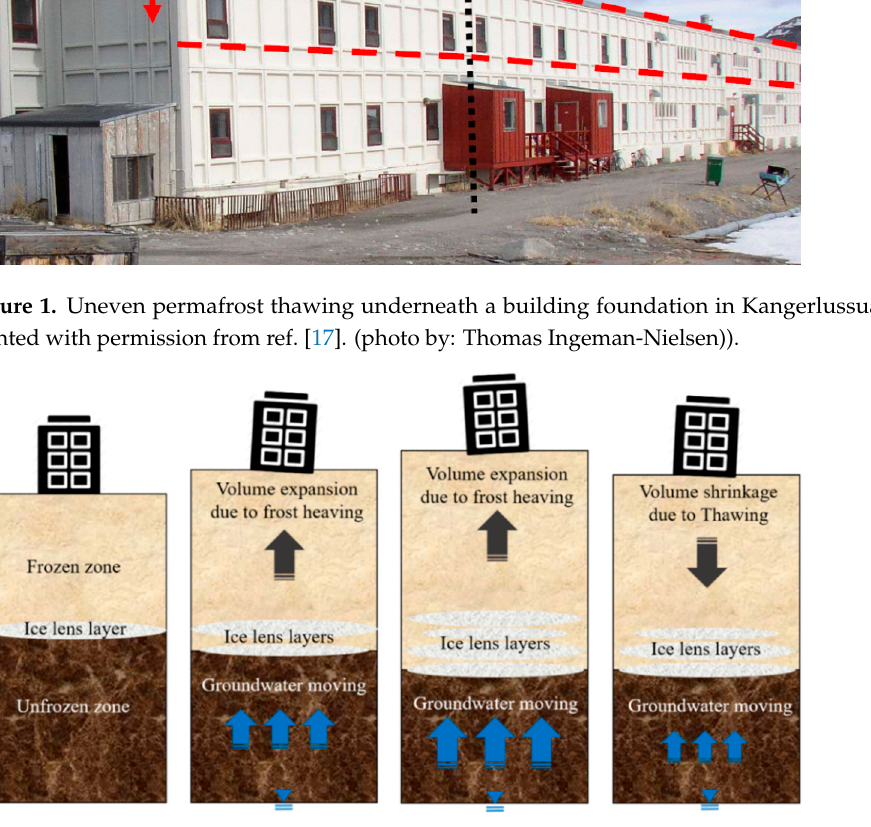
Figure 2. The sequence of subsidence events caused by frost heave and thawing (Reproduced from [18]).